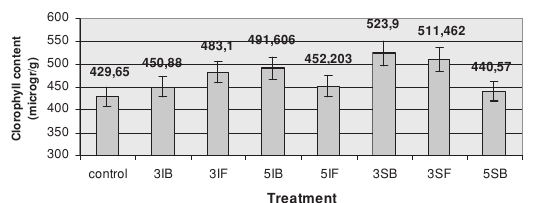
Figure 1. The effect of treatments on chlorophyll content of the leaves of